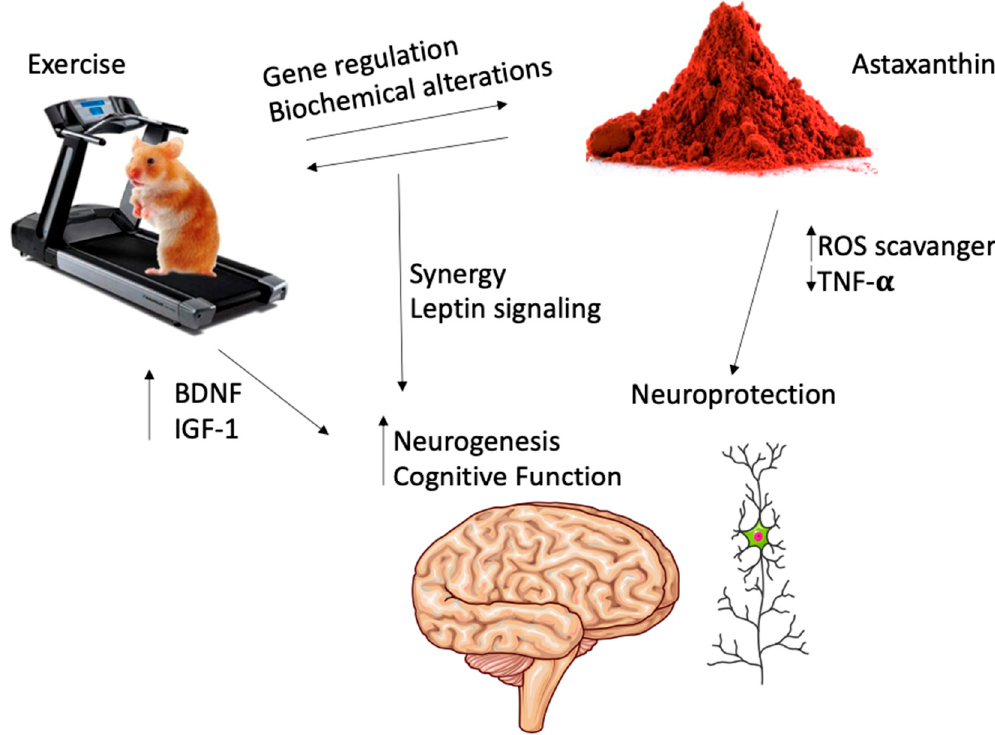
Figure 3. Astaxanthin and exercise modulating cognitive function. ROS: reactive oxygen species. TNF- α : tumor necrosis factor-alpha. BDNF: brain-derived neurotrophic factor. IGF-1: insulin-like growth factor one. (Illustrations provided by Servier Medical Art, licensed under Creative Commons Attribution 3.0 unported license (https://smart.servier.com accessed in 19 May 2021)).